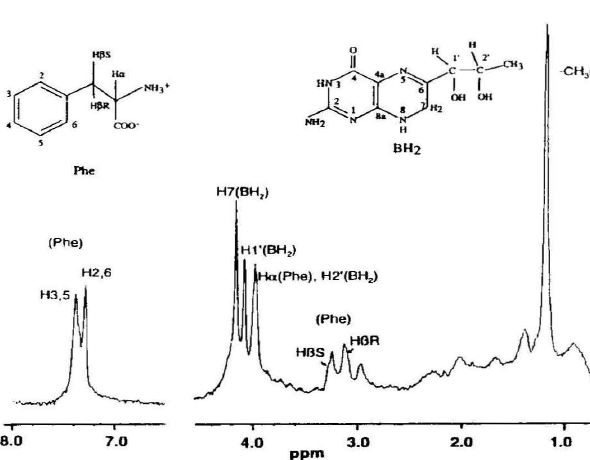
Figure 1. IH-NMR spectrum of L-Phe and L-erythro-7, 8-dihydrobiopterin (BH 2) in the presence of apo-TH1. The 400-MHz IH-NMR spectrum (100 transients) was taken at 273 K in samples (0.5 ml) prepared in 0 2 0 con taining 0.1 mM THl, 5 mM BH 2, 5 mM L-Phe, 0.1 M KCI and 0 .1 M deuterated K-phosphate buffer, pH*